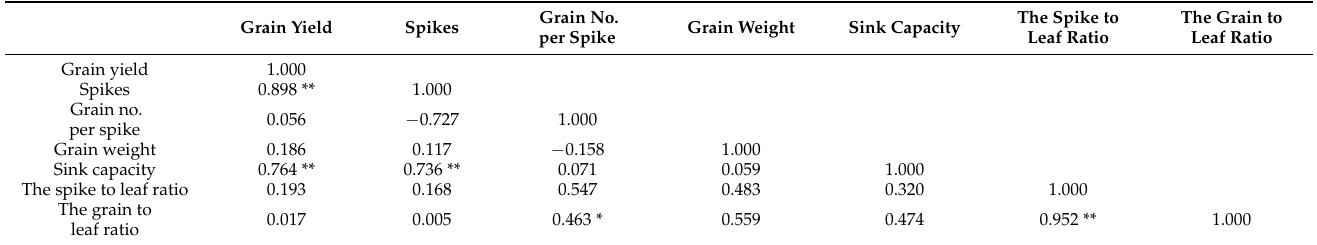
Table 7. The correlation analysis of yield components and yield of hybrid